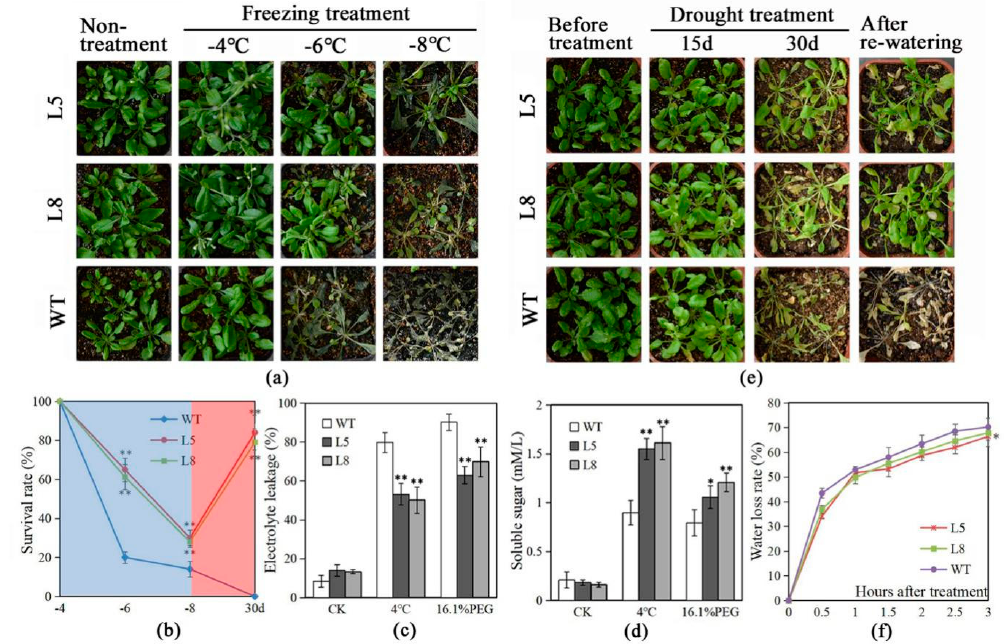
Figure 4. Overexpression of LlMYB3 in Arabidopsis improves the freezing and drought tolerance. Performance of wild-type (WT) and LlMYB3 transgenic lines after freezing ( a ) and drought ( e ) treatments. ( b ) Survival rate of plants in ( a ) under freezing temperatures (blue region) and in ( e ) after drought treatment for 30 days (red region). Each data point is the mean of four experiments, and each experiment comprises 30 plants. Relative electrolyte leakage ( c ) and soluble sugar content ( d ) in WT and LlMYB3 transgenic lines after 4 ◦ C and 16.1% PEG6000 treatments for 3 h. ( f ) Water loss rate of leaves from WT and transgenic Arabidopsis. The data represent the means from three experiments. The bars show the SD. Significant differences between the transgenic and WT lines are indicated as * 0.01 < p < 0.05 and ** p <